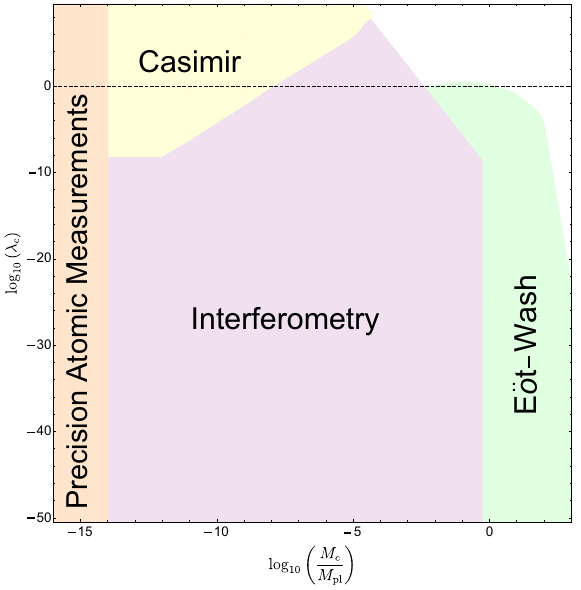
Fig. 5 Current bounds on the parameters M c and Λ for n = − 4 chameleon models. The regions excluded by each specific test are indicated in the figure. Comparing Eqs2.16 with 2.17 reveals that λ c = (Λ/Λ DE ) 4 and so the values of λ c plotted here cover the same range of Λ as Fig. 4. The black dashed line at λ c = 1 therefore corresponds to the dark energy scale Λ = Λ DE